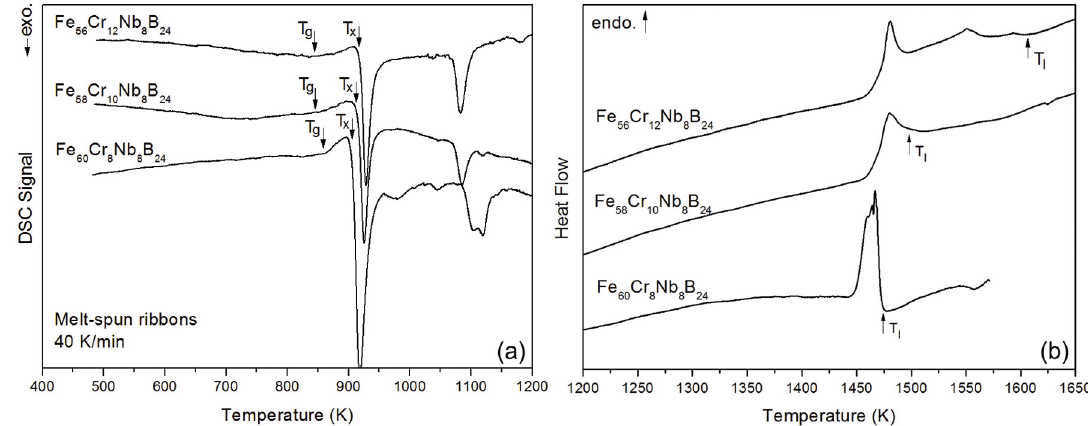
Figure 1: (a) DSC thermograms for as-quenched ribbon. Arrows indicate glass transition temperature (T (T ); (b) DTA scans for the glass-forming alloys. Arrows indicate liquidus temperature (T x Table 1: Thermal characteristics of as-quenched ribbon and calculated critical thickness for glassy structure formation (Z